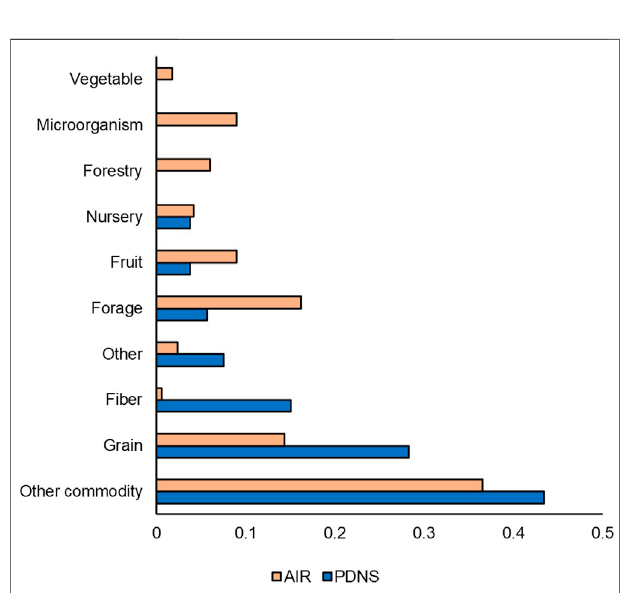
FIGURE6| Organism comparison.Unique organisms werecategorized based on USDA Quick Stats & ERS crop designations, and researcher- assigned categories to cover organisms not addressed by USDA designations(i.e.microorganisms).Percentagesindicatetheshareofthe total number of times that category occurred in the data set. Comparison is from 2011 to 2020.